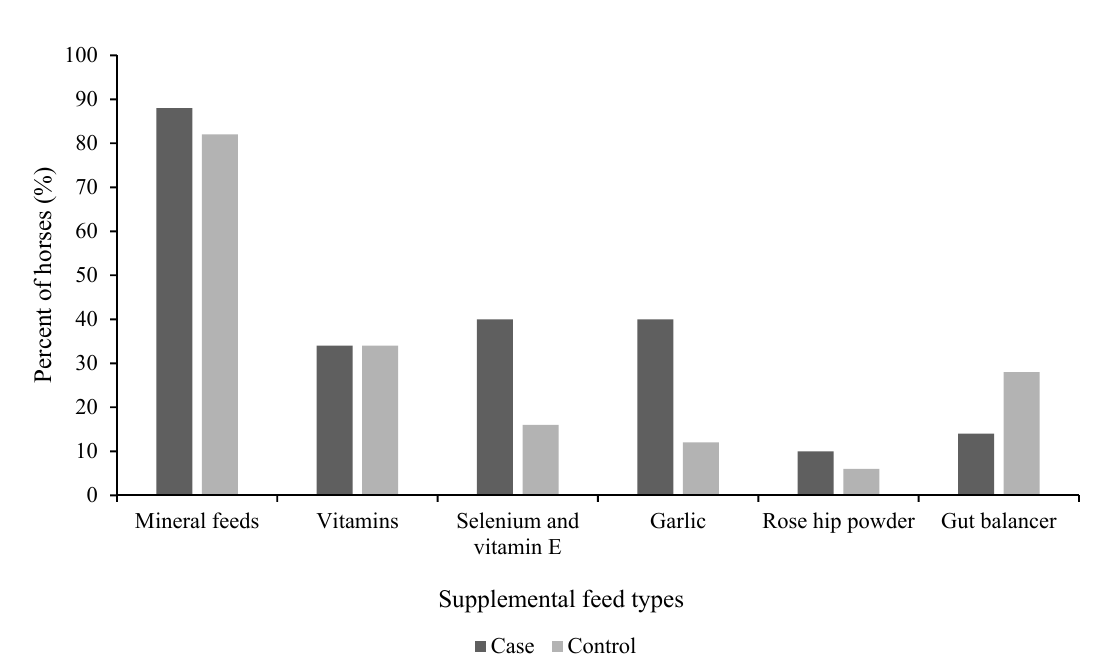
Figure 3. Proportion of horses with (case, n = 50) and without (control, n = 50) free faecal liquid fed different types of supplement feeds. Multiple supplement feeds may have been fed to the same horse, resulting in a sum exceeding 100%. p > 0.05 for all feed types.